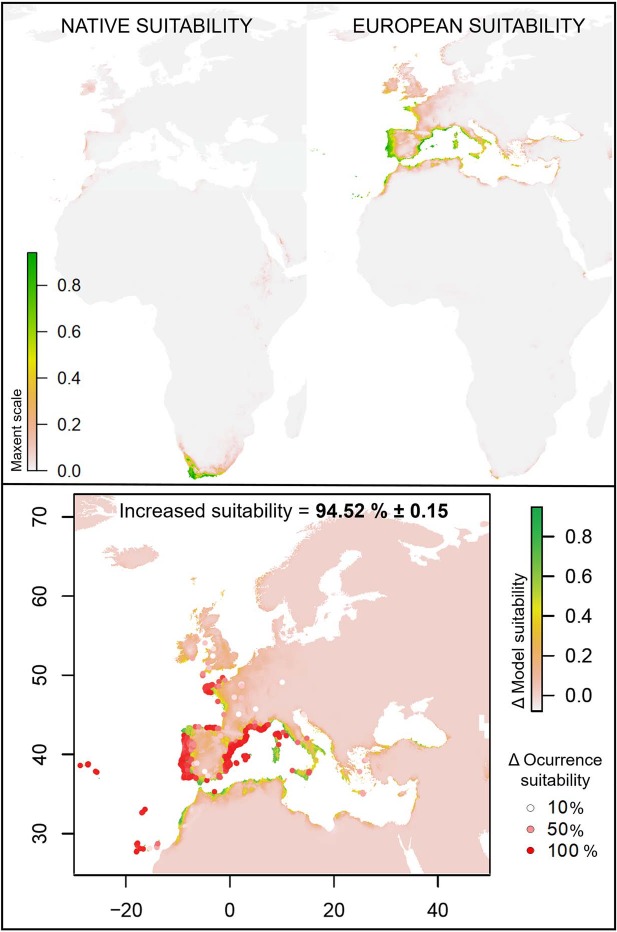
MaxEnt predicted suitability considering the native and the European occurrences of C. edulis (Native and European suitability, respectively) and difference between both projections (Increased suitability). Dots correspond to actual invasive occurrences, coloured by the percentage of increased suitability between native and European projections.